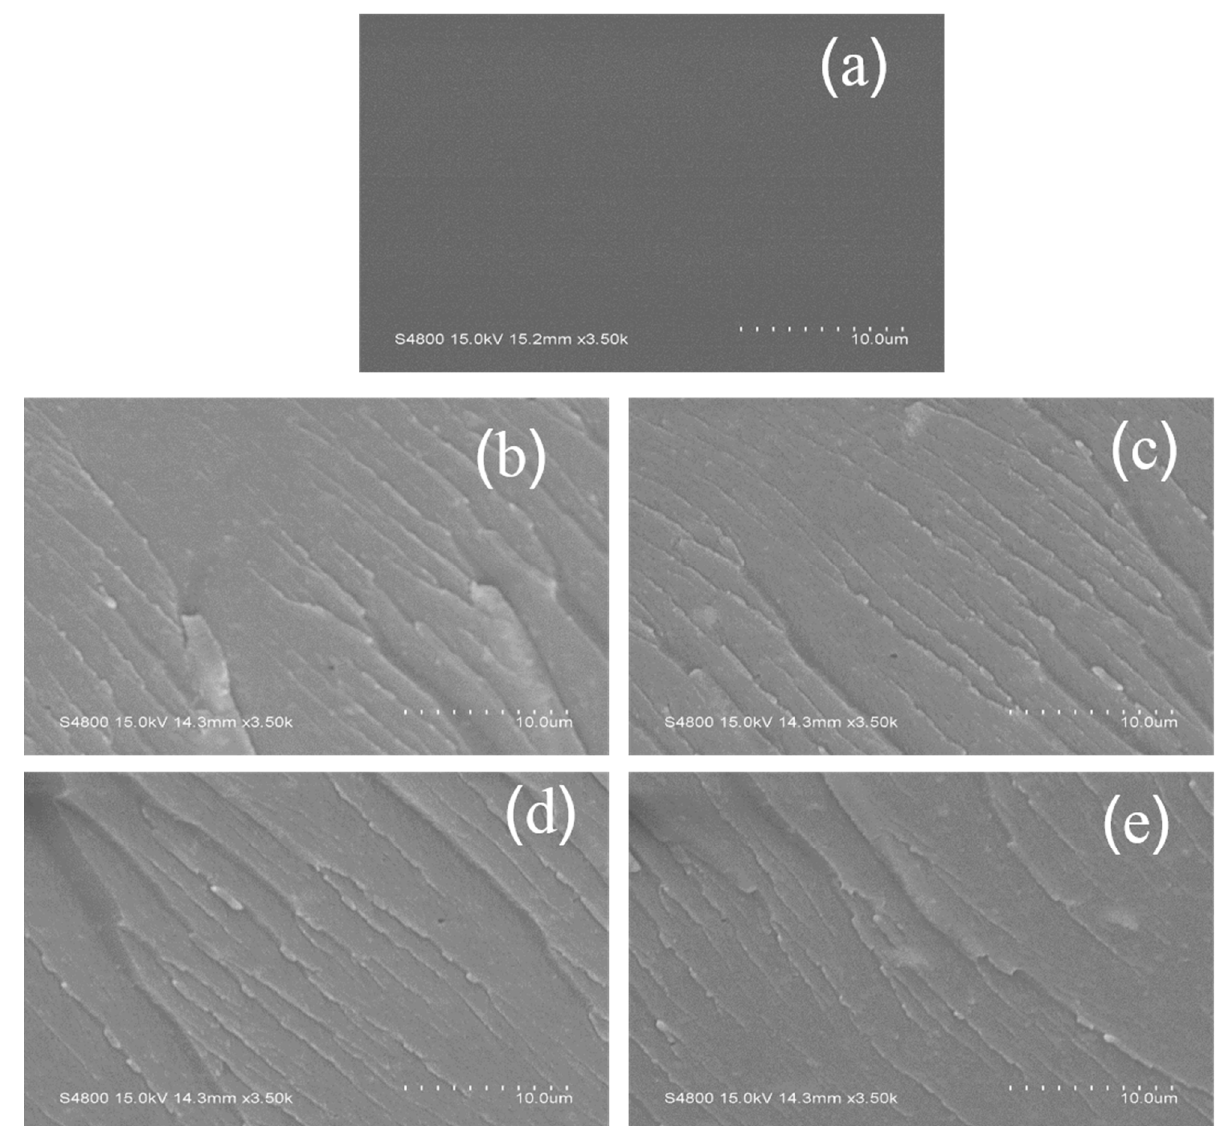
Figure 5. SEM images of cryo-fractured sections of CS control and CS/STiO 2 nanocomposite membranes with different STiO 2 contents. CS/STiO 2 – 0 ( a ), CS/STiO 2 – 1 ( b ), CS/STiO 2 – 3 ( c ), CS/STiO 2 – 5 ( d ) and CS/STiO 2 – 7( e ).